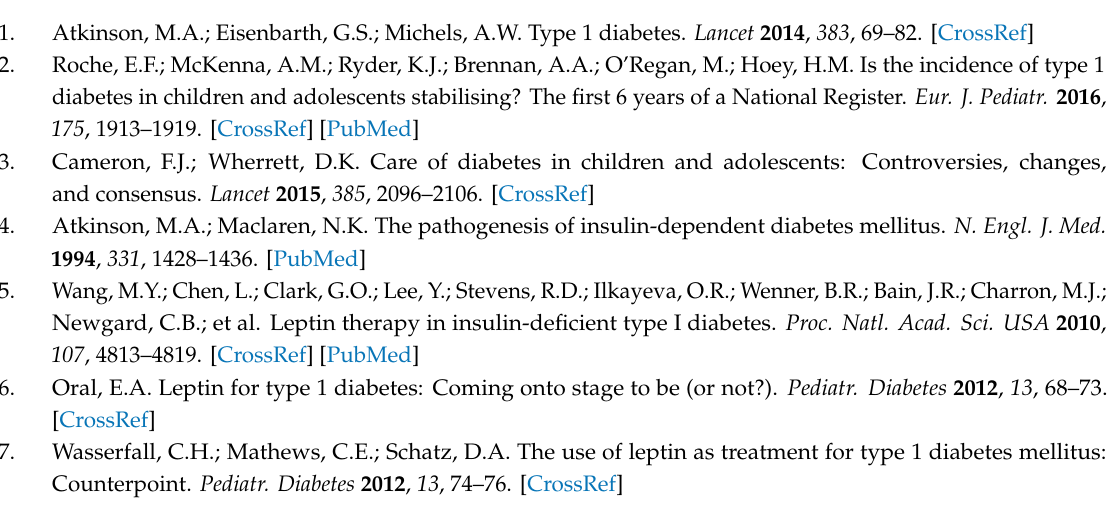
Table S1: Cross-sectional comparison (healthy controls vs T1DM patients) of serum parameters at each time point via Mann-Whitney rank sum tests or t-tests in case of normal distribution; Table S2: Cross-sectional comparison (healthy controls vs T1DM patients) of VOC concentrations at each time point of blood drawing via Mann-Whitney rank sum tests or t-tests in case of normal distribution.; Table S3: Pearson product moment correlation analysis between VOCs and serum parameters.; Table S4: Pearson product moment correlation analysis between VOCs and interstitial glucose